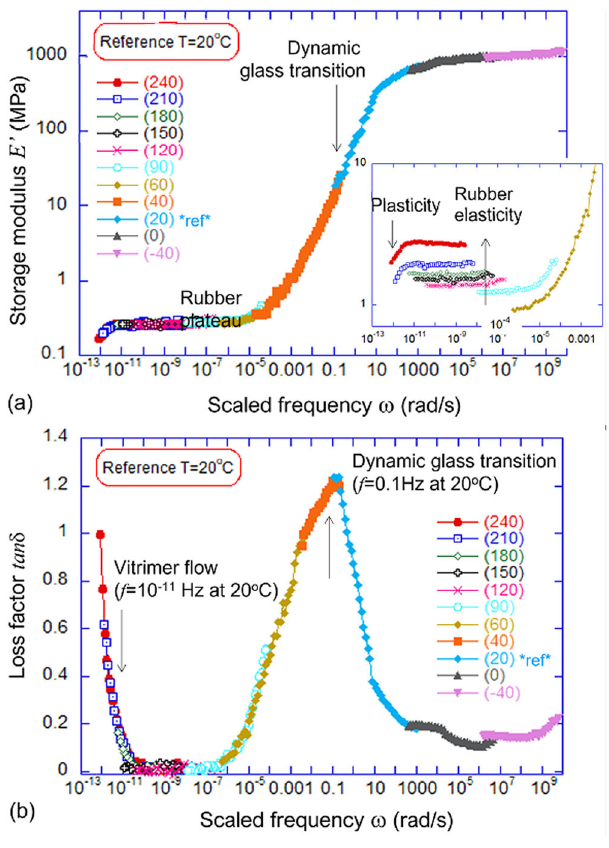
Fig. 2 | The Master Curves for the Leibler ’ s benchmark vitrimer, obtained by time-temperature superposition of frequency scans of the linear dynamic responseatdifferenttemperatures.a Thetensilestoragemodulus E 0 ispresented as function of scaled frequency spanning the full range. Note that in the rubber- elastic regime the low-frequency rubber modulus grows with temperature, and needs to be scaled down proportionally for the proper Master Curve at 20°C, see Inset. b The matching Master Curve for the loss factor tan δ ð ω Þ , for the reference T =20°C. Both plotsshow the dynamicglass transition, and the regime ofvitrimer fl ow emerging at very low